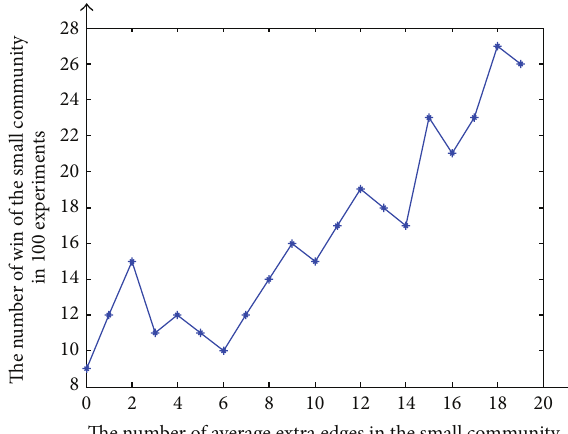
Figure 8: The Y-ray represents the number of win of the small community in 100 experiments. The X-ray represents the number of average extra edges in the small community. There is no noise in the model and there are 80 nodes in the small community.